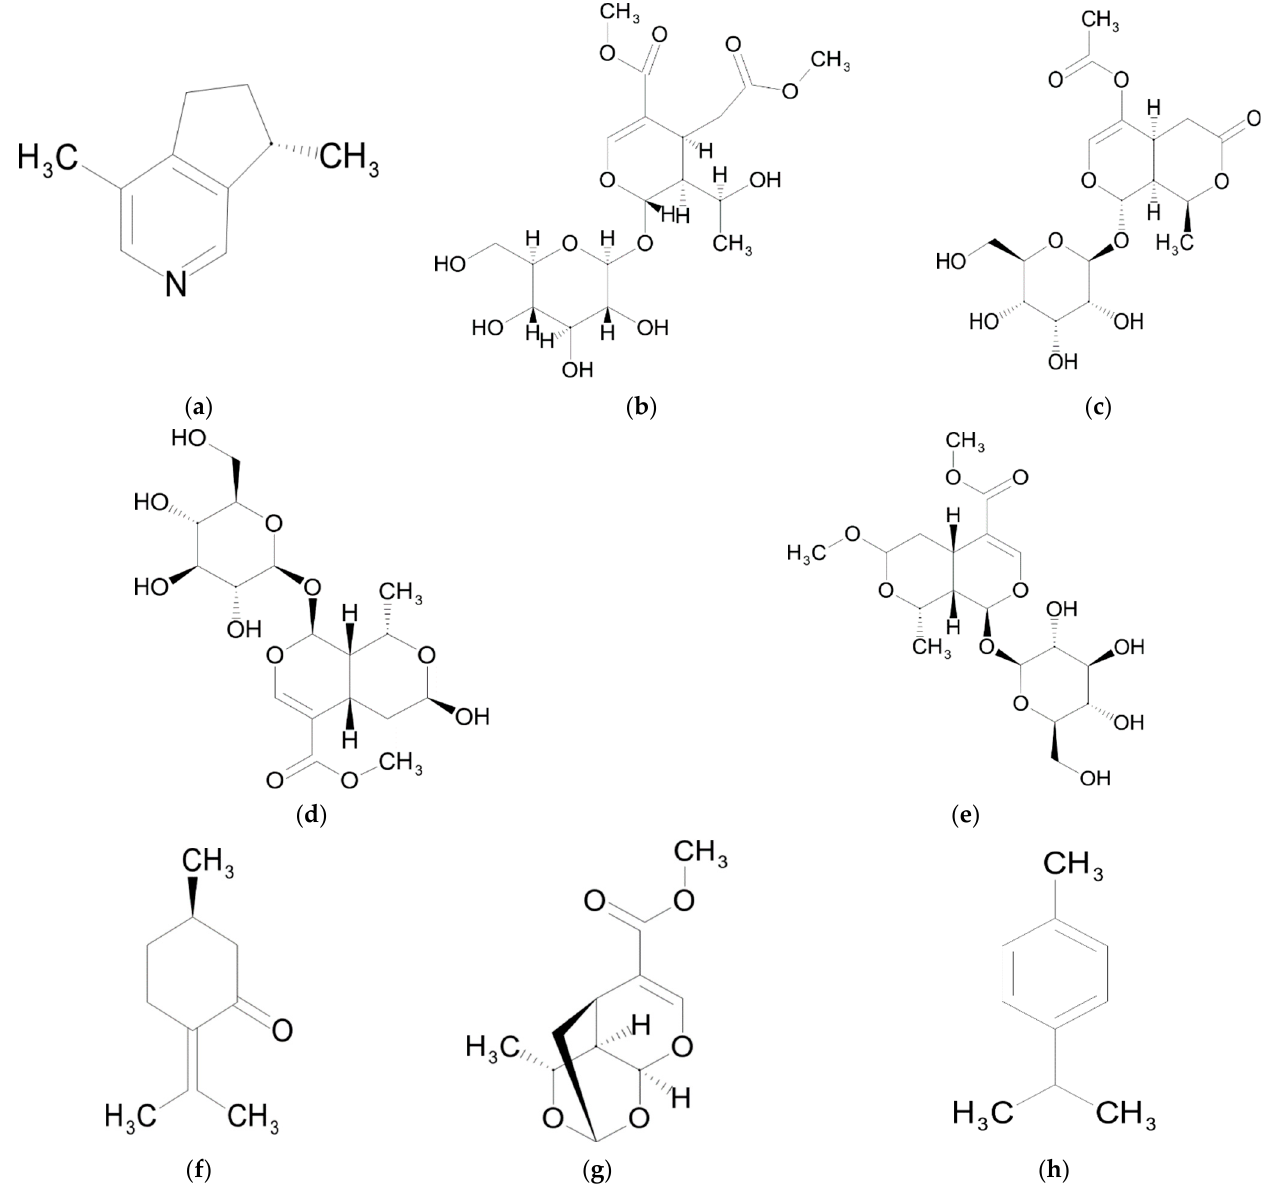
Figure 3. Chemical structures of monoterpenes from Sarraceniaceae species: ( a ) actinidine; ( b ) alpigenoside; ( c ) kingiside; ( d ) morroniside; ( e ) methylmorroniside; ( f ) pulegone; ( g ) sarracenin; ( h ) p-cymene.